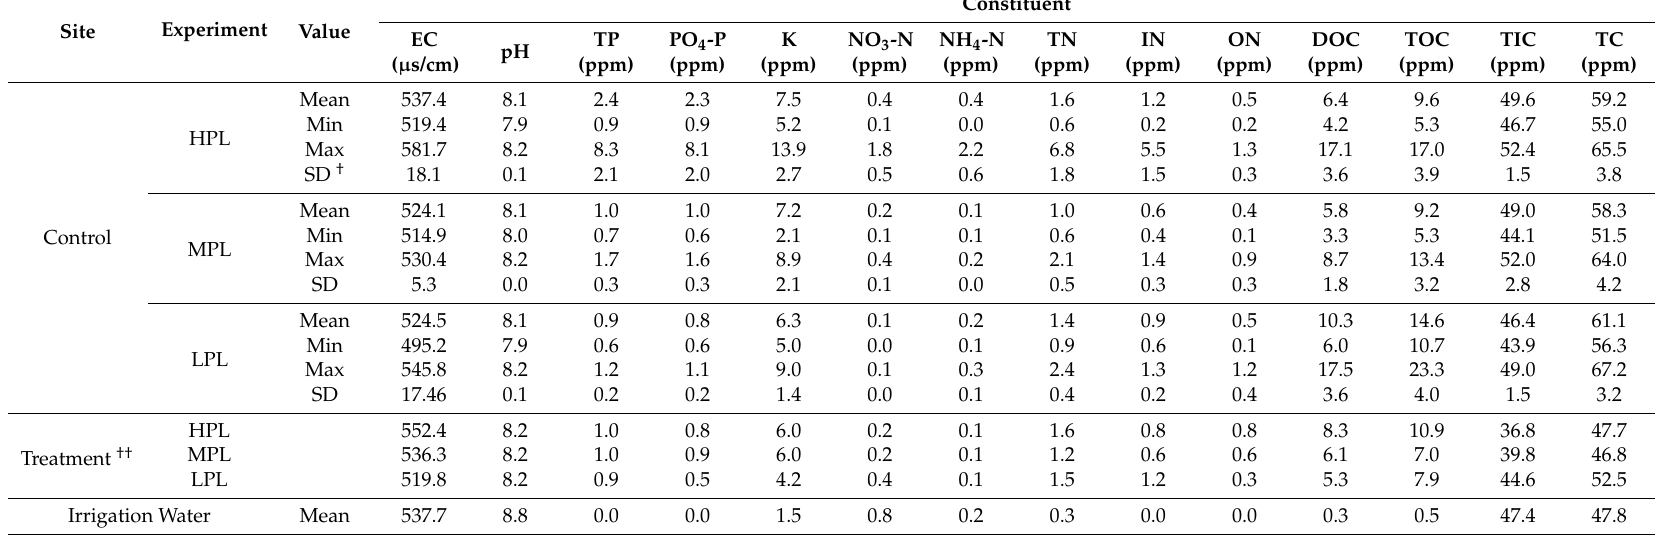
Table 2. Summary of Runoff Quality